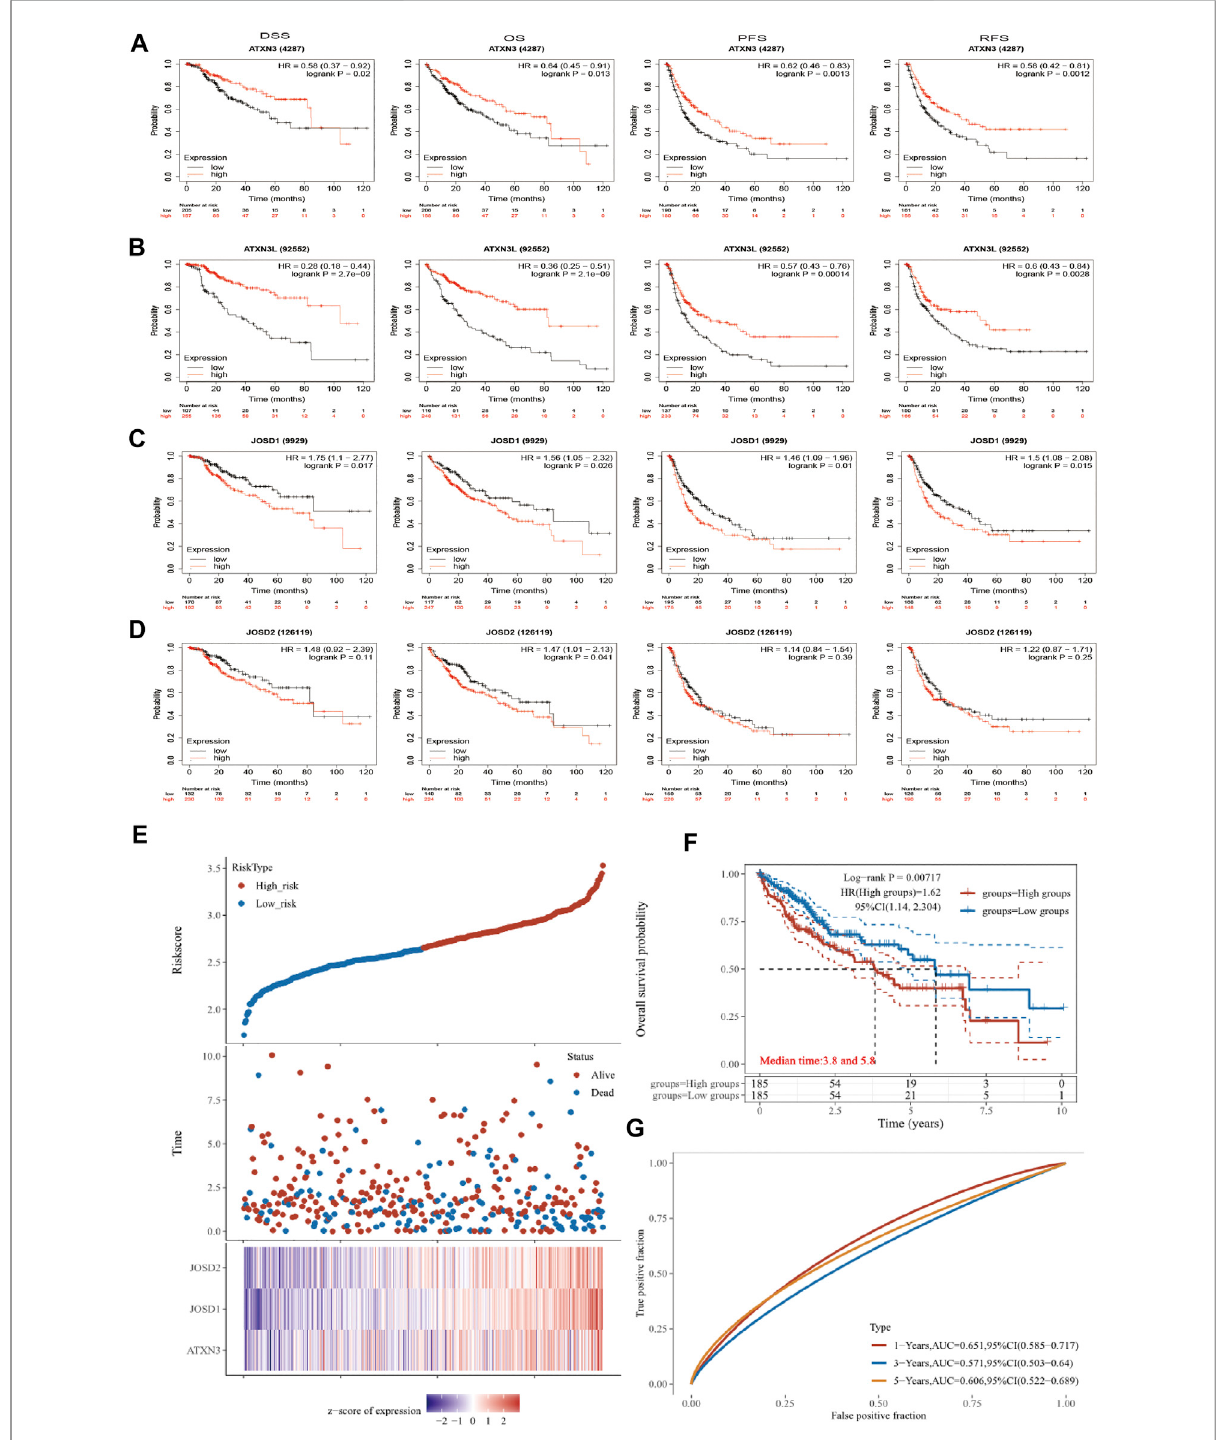
FIGURE 7 (A-G) The prognosis of MJDs expression level in HCC patients. The HCC specimens were divided into two groups according to the median expressionlevelsofMJDsfamilymembers.Thedisease-speci fi csurvival(DSS,n=362),overallsurvival(OS,n=364),progression-freesurvival(PFS,n = 370), and relapse-free survival (RFS, n = 316) were compared between patients across high and low expression of MJDs family members. TCGA database screening results for 371 HCC patient samples, including risk score, survival time, and survival status. The middle shows the survival matchingtotheRiskscoreofvarioussamples,whilethetopshowstheRiskscorescatterplotfromlowtohigh,withdifferentcolorsdenotingdistinct risk categories. Time and survival status scatter plot distribution; the expression heat map of the signature ’ s genes is shown in the bottom fi gure (E)